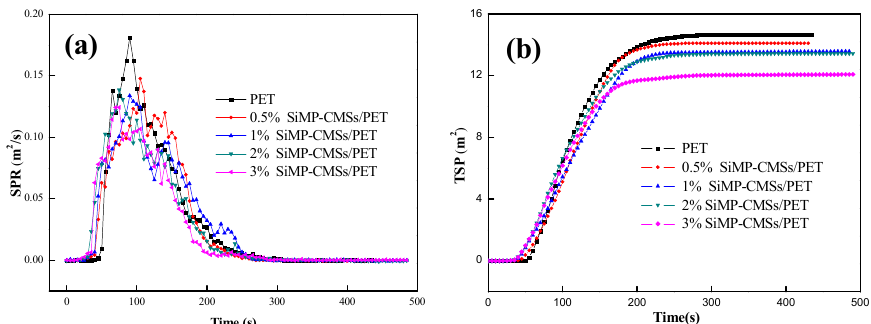
Figure 7. Smoke production rate (SPR) ( a ) and total smoke production (TSP) ( b ) curves of the SiMP-CMSs/PET composites. Table 3. Smoke parameters of the SiMP-CMSs/PET composites. SEA, specific extinction area; SP, smoke production.